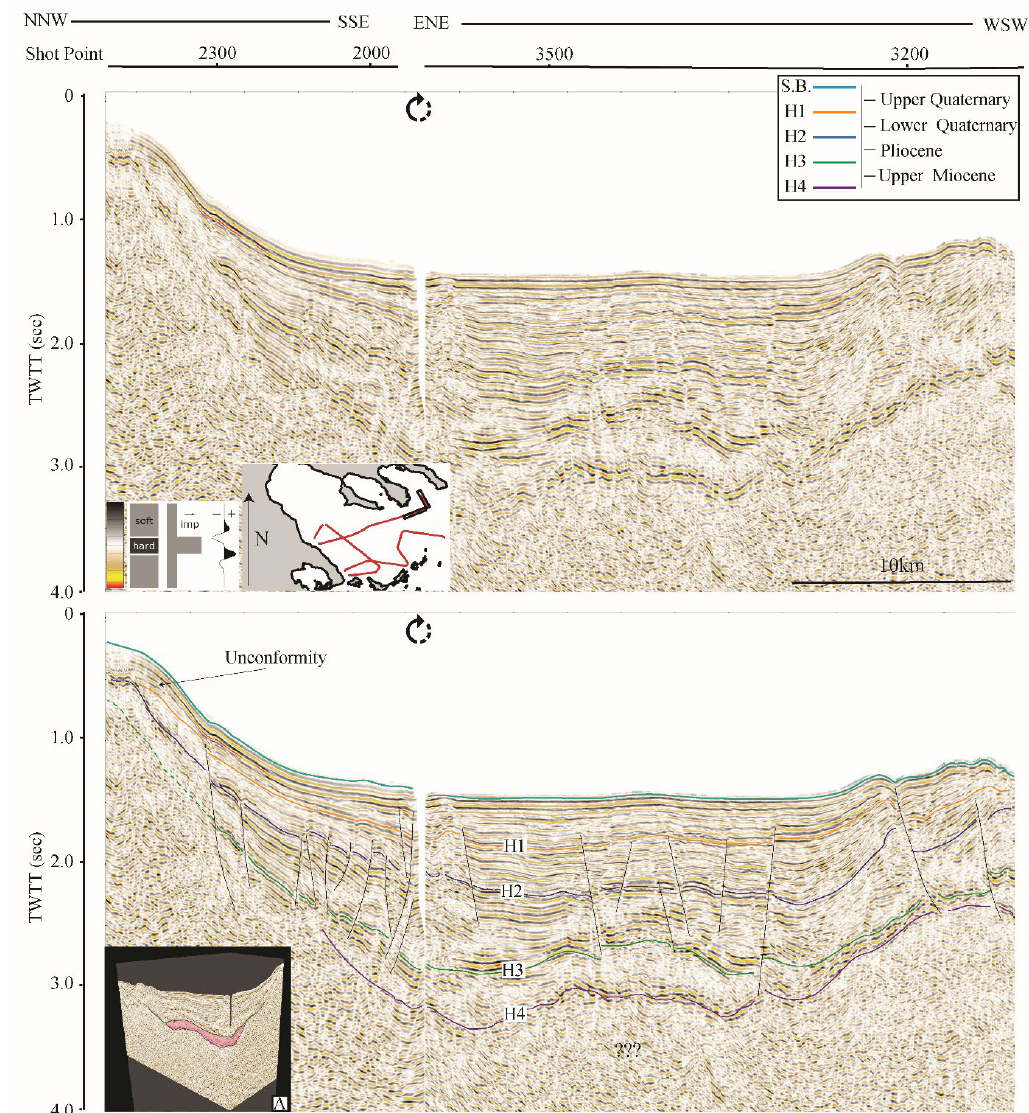
Figure 10. Seismic Line PR-OP. Upper part: un-interpreted set of regional seismic profiles. Lower part: interpreted seismic section with highlighted key horizons and the most prominent tectonic elements. ( A ) 3D perspective of the orientation of the three profiles, with SU.4 highlighted.